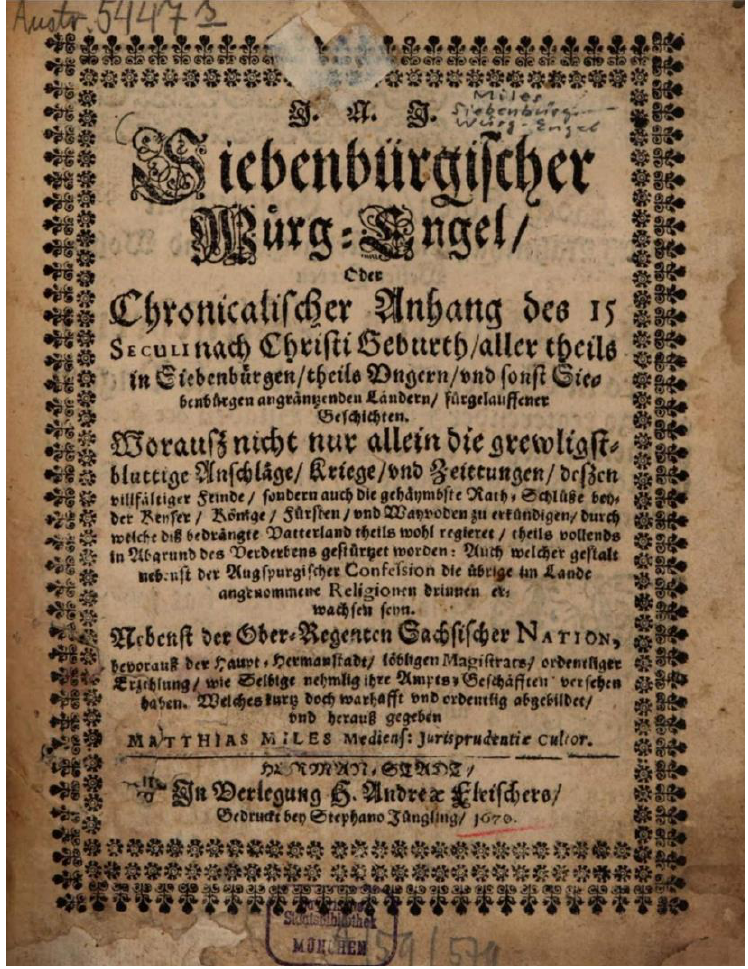
Figure 1. Title page of Matthias Miles’ Siebenbürgischer Würg-Engel, which reads “Transylvanian destroying angel or chronological appendix of the stories that occurred in Transylvania, partly in Hungary and in the other countries bordering on Transylvania in the 15th century AD, from which not only the horrific bloody attacks, wars, and news from various enemies of the country emerge, but also the most secret decisions of all emperors, kings, princes, and voyvods, through which its oppressed fatherland flourished in part, in part completely plunged into the abyss of ruin: in what manner besides the Augsburg confession the rest of the country’s accepted religions have emerged”. Courtesy Bayerische Staatsbibliothek München.